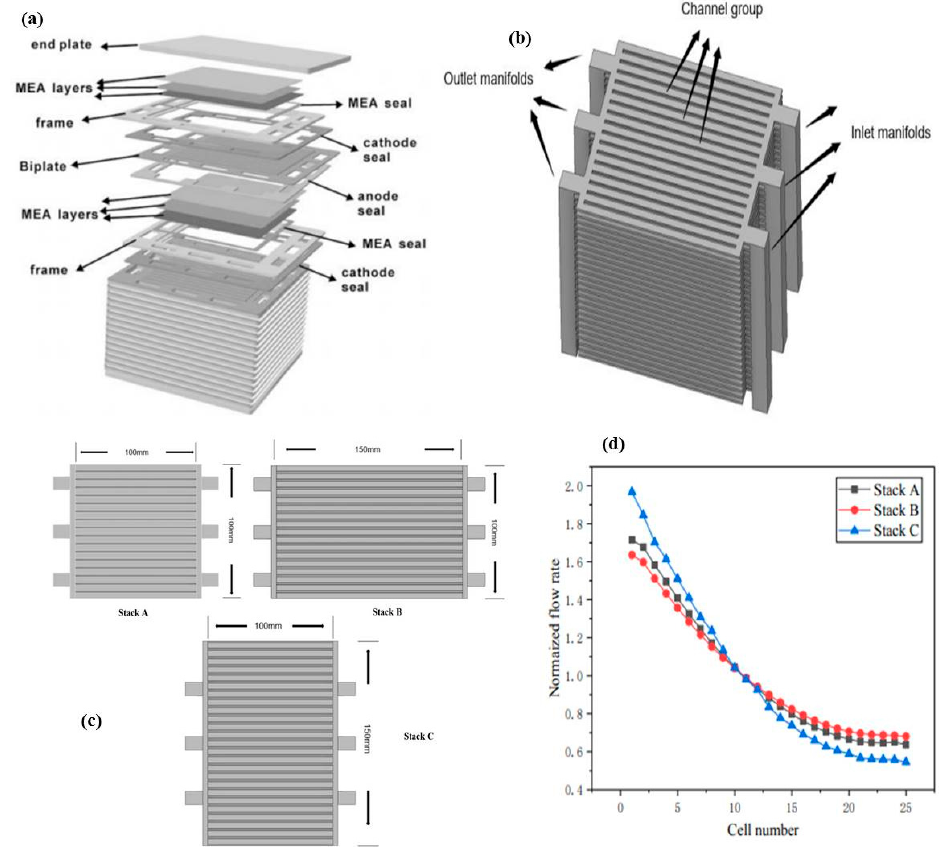
Figure 5. ( a ) Structure of a typical fuel cell [54] reproduced with permission from reference [54], copyright 2009, Elsevier; ( b ) modeling of cathode side gas path of the designed stack; ( c ) three different types of stacks employed in 25 cell-PCFCs; ( d ) normalized flow rate distribution on PCFC piled stacks A, B, and C, reproduced from the reference [53], open access.